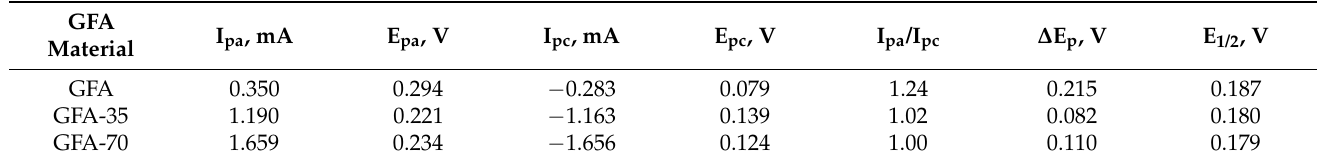
Table 2. CV parameters determined from cyclic voltammograms recorded in K 4 [Fe(CN) 6